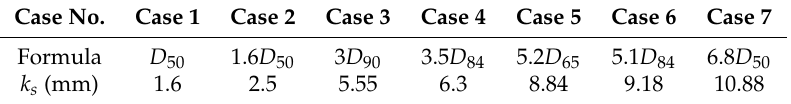
Table 3. Roughness values of cases.